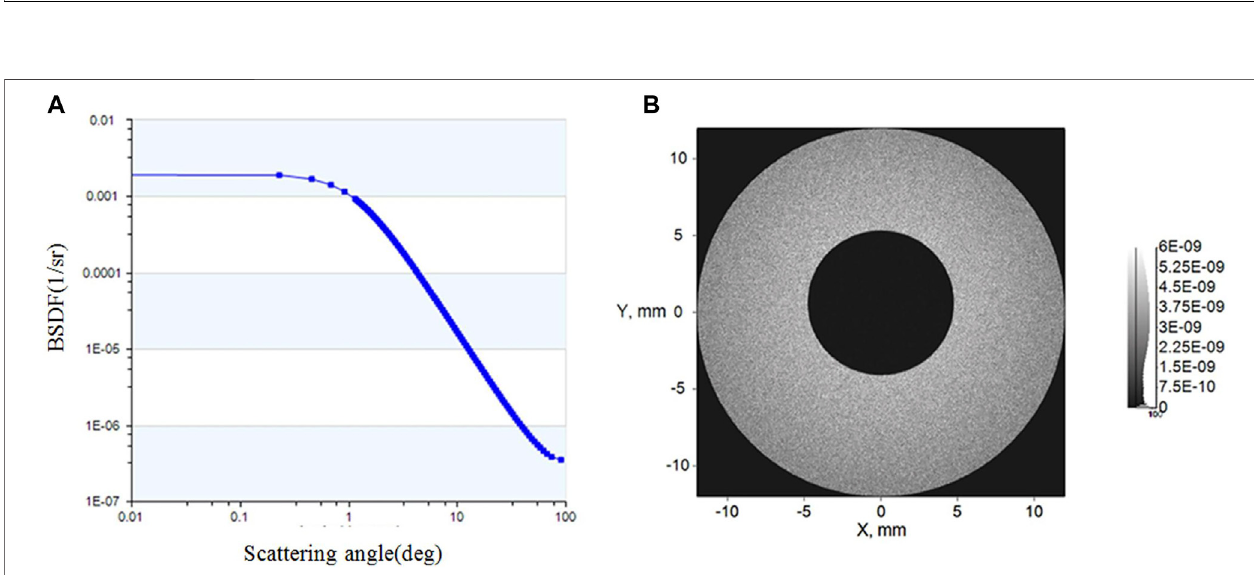
FIGURE 11 | Scattered stray-light simulation results from particulate contamination with CL100 at 700.0 nm. (A) BSDF curve as a function of the scattering angle. (B) Stray-light distribution at the focal plane.